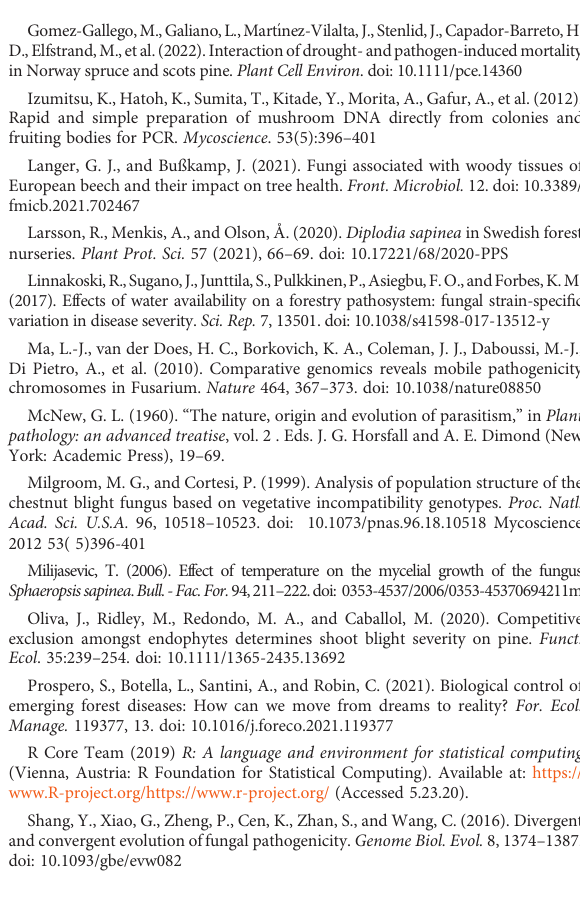
SUPPLEMENTARY FIGURE 1 The soil moisture data measured (60 trees) over the duration of the experiment for the three different water treatments (100% blue, 60% orange, 25%